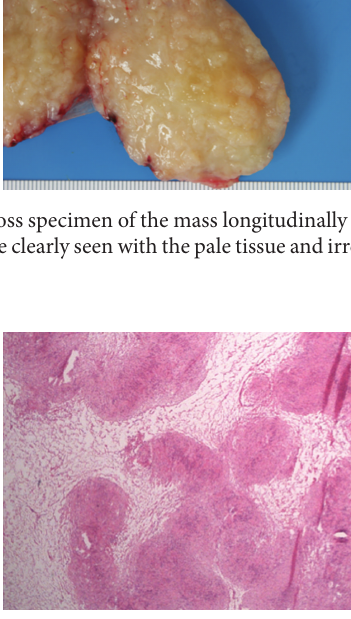
Figure 4: Microscopic appearance of spindle cell